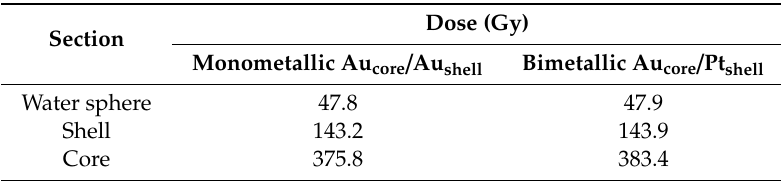
Table 3. Dose deposition to sensitive targets: water sphere embedding nanoparticles, shell, and core of mono- and bimetallic nanoparticles.